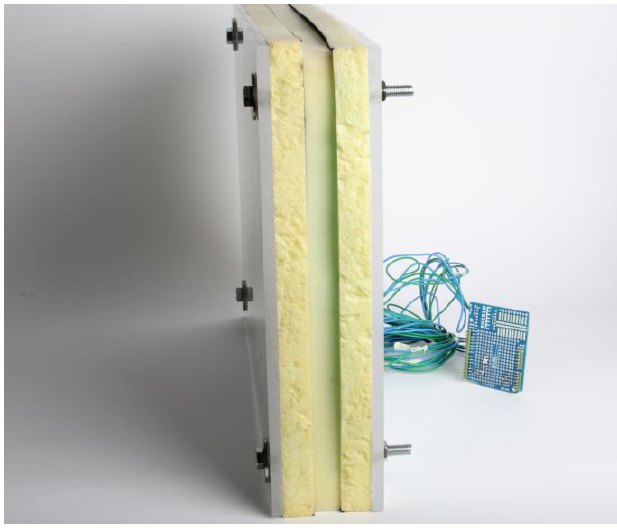
Figure 2. The wired prototype. The rightmost part can be mounted on a chimpanzee enclosure. The animals come in contact with the leftmost